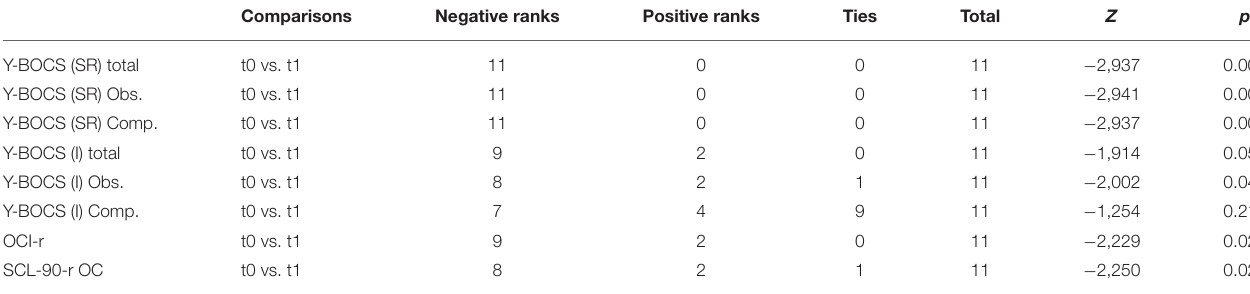
TABLE 3 | Wilcoxon Signed Ranks Test for study variables. Comparisons Negative ranks Positive ranks Ties